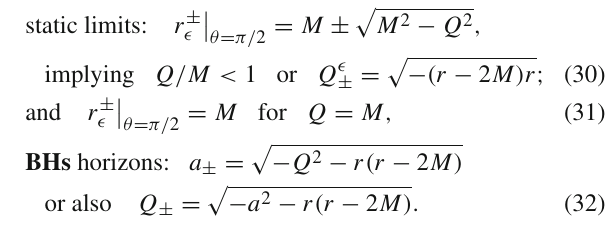
Fig. 19 Kerr–Newman spacetimes. The frequencies ω H = ω ± ( r ± ) at the horizons r ± – see Eq. (29). Left panel: curves ω = constant. Arrows indicate the increasing magnitude of the frequencies ω − Q , described by metric (1) with (cid:2) K N ≡ r 2 + a 2 + Q 2 − 2 Mr